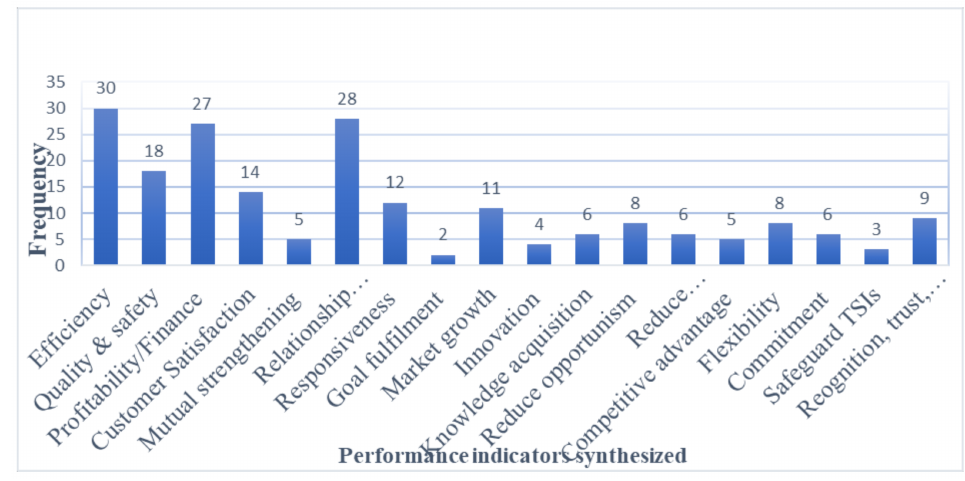
Figure 3. The performance indicators ordered by